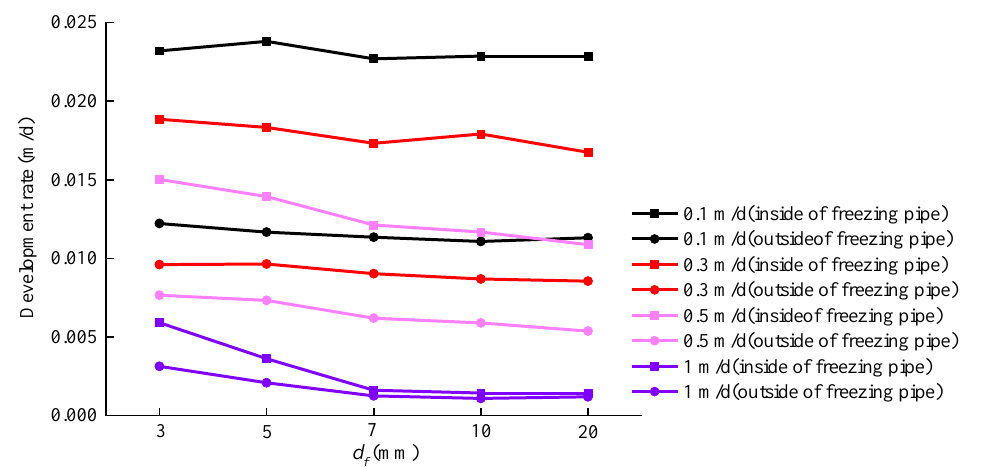
Figure 12. Development rate of frozen wall of fractured rock mass with different fracture apertures under different groundwater seepage velocities.